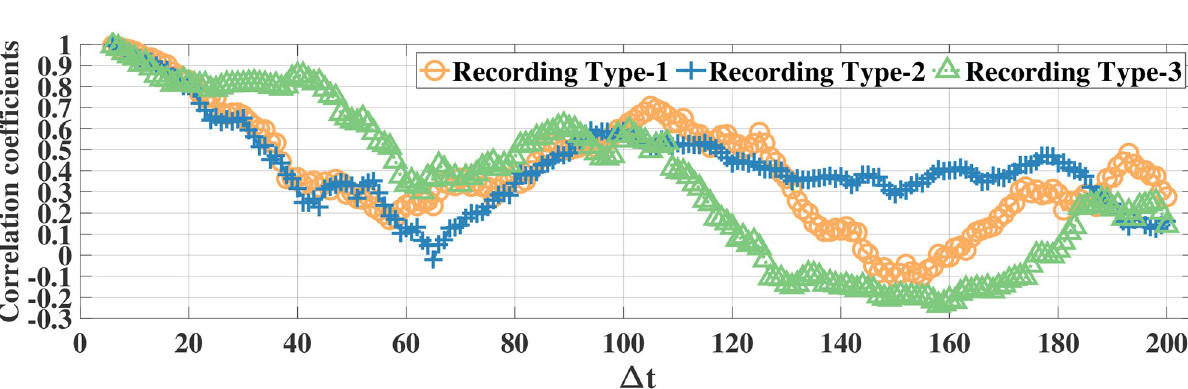
Fig 5. Correlation coefficients of the raw signals of feature blink rate in the MPIIPrivacEye dataset. The values are calculated over a time difference of Δ t (Each time step corresponds to 1s) w.r.t. the samples at the fifth time instance.